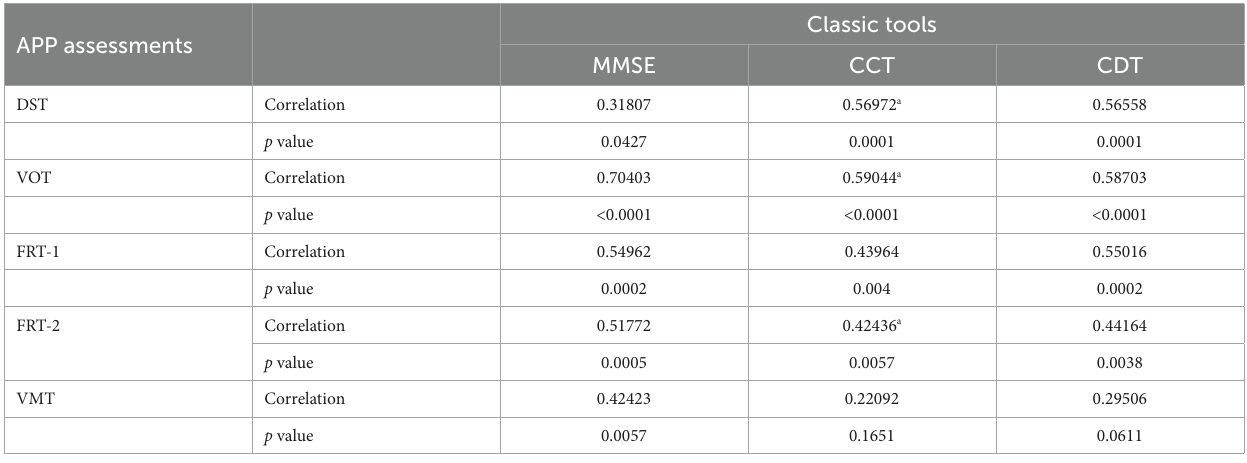
TABLE 2 Correlation analysis between APP assessments and classic tests scores.